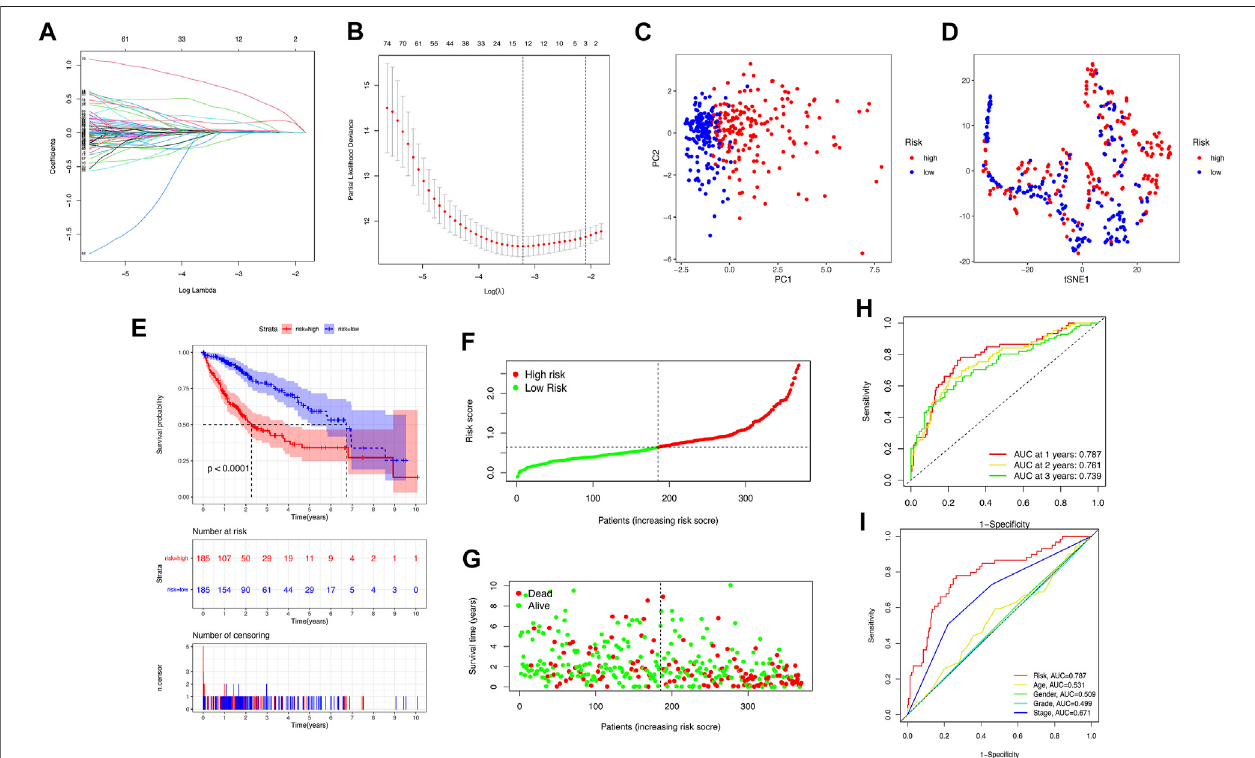
FIGURE 2 | Construction of the pyroptosis-related lncRNA prognostic model for predicting prognosis of HCC patients. (A) Twelve pyroptosis-related lncRNA signatureswereselectedbyLASSOCoxmodels. (B) Cross-validationfortuningparameterselectionintheLASSOmodel. (C,D) Principalcomponentanalysis(PCA)and t-distributed stochastic neighbor embedding (t-SNE) analysis between the high- and low-risk groups. (E) The Kaplan – Meier curve survival analysis between the high- and low-risk groups. (F,G) The risk score distribution and survival status distribution of HCC patients in two risk groups. (H) ROC analysis for OS prediction including 1, 2, and 3 years of HCC patients in the training set. (I) ROC curve analysis compares the predictive power of risk score and other clinicopathological parameters.